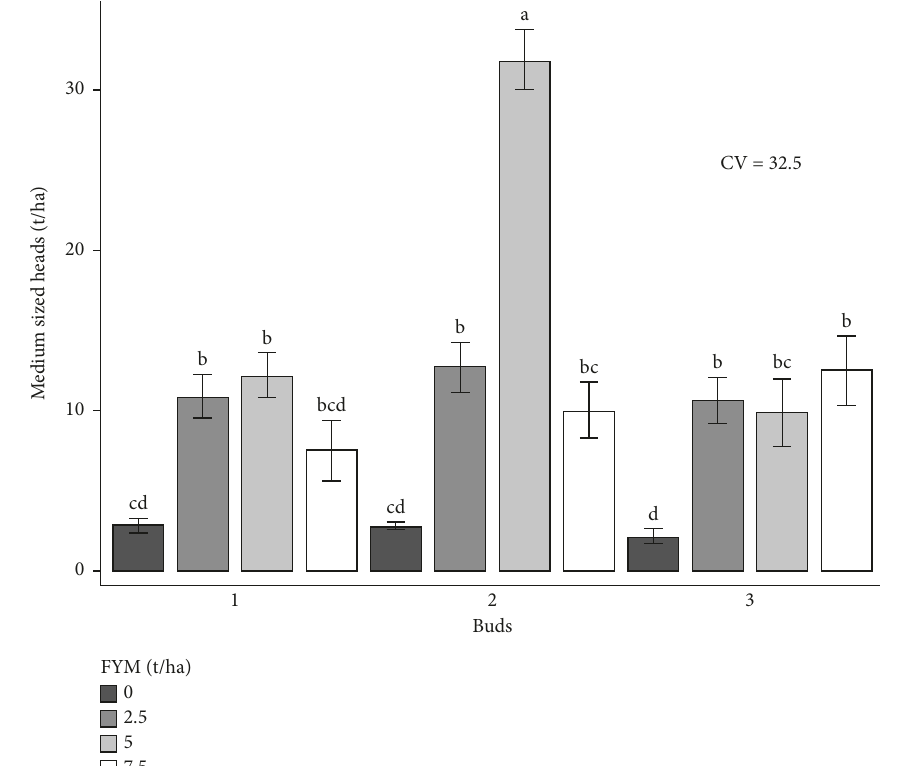
Figure 7: Medium-sized heads as influenced by the interaction effect of bud numbers and farmyard manure fertilizer rates.